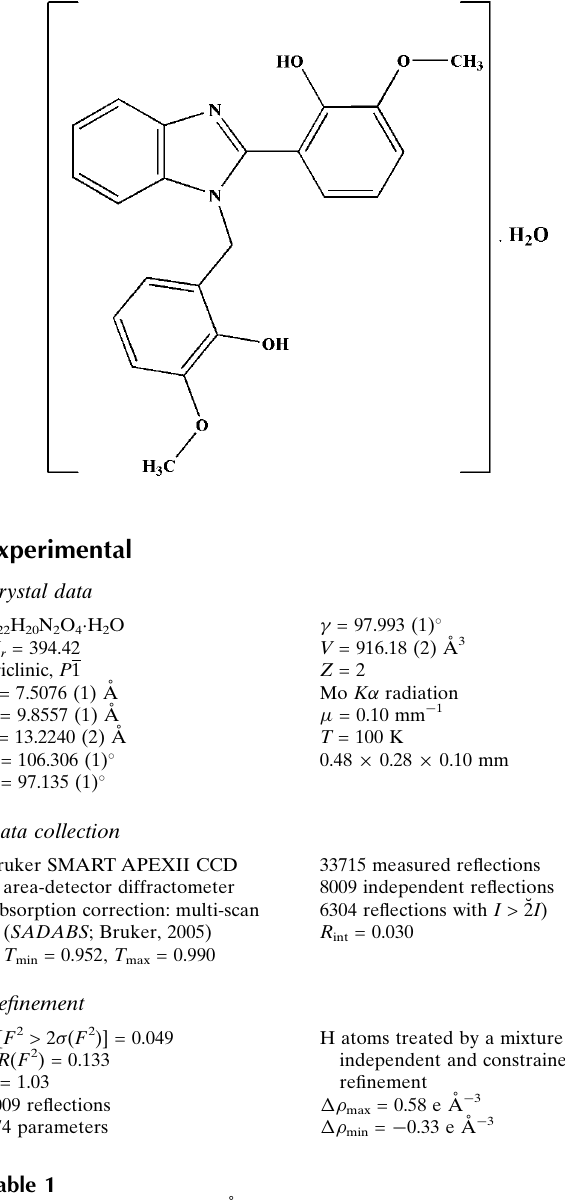
Hydrogen-bond geometry (A˚ , (cid:2)